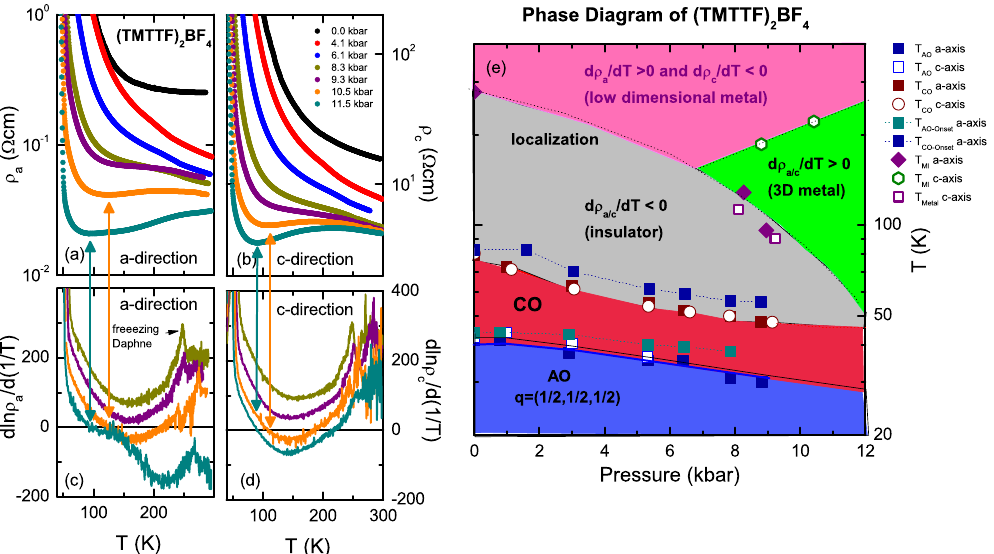
Figure 13. The panels on the left display the temperature dependence of the resistivity of (TMTTF) 2 BF 4 measured for different hydrostatic pressure applied with the main focus on the metal-insulator transition and charge localization. ( a ) The on-chain resistivity ρ a ( T ) exhibits the development of a minimum as pressure increases. ( b ) Resistivity ρ c ( T ) perpendicular to the stacks for different pressure values. ( c,d ) Pressure evolution of the resistivity derivative dln ( ρ ) /d ( 1/ T ) as a function of temperature for both orientations. The metal-insulator transition is indicated by the arrows. Also seen is the freezing of the pressure transmitting oil Daphne 7373. ( e ) In the phase diagram of (TMTTF) 2 BF 4 different electronic states are depicted as derived from dc transport experiments. Upon cooling the low-dimensional metal exhibits a charge localization that moves from about room temperature down to below 100 K as pressure increases. For pressure above 8 kbar a three-dimensional metallic phase develops. At lower temperatures charge order and anion order appear subsequently. Both phase boundaries move towards lower temperature with increasing